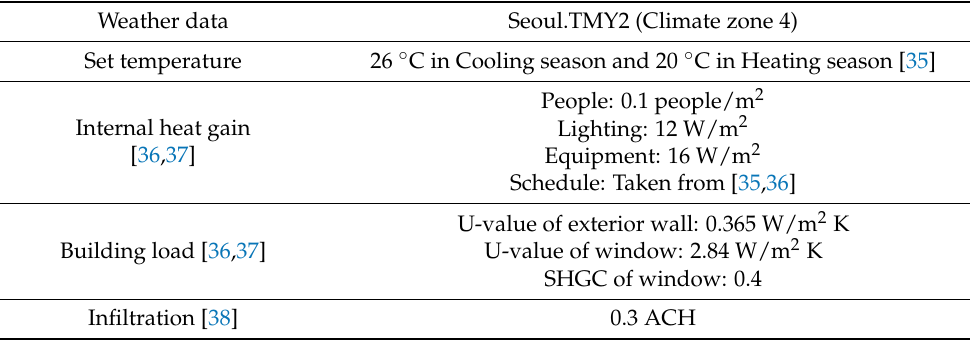
Table 1. Simulation conditions.